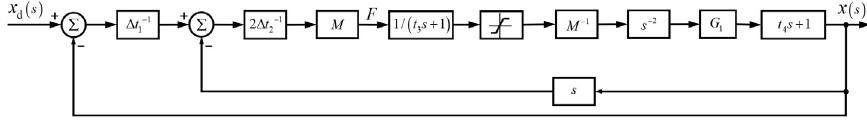
Figure 6. A single joint model of the virtual force sensor.